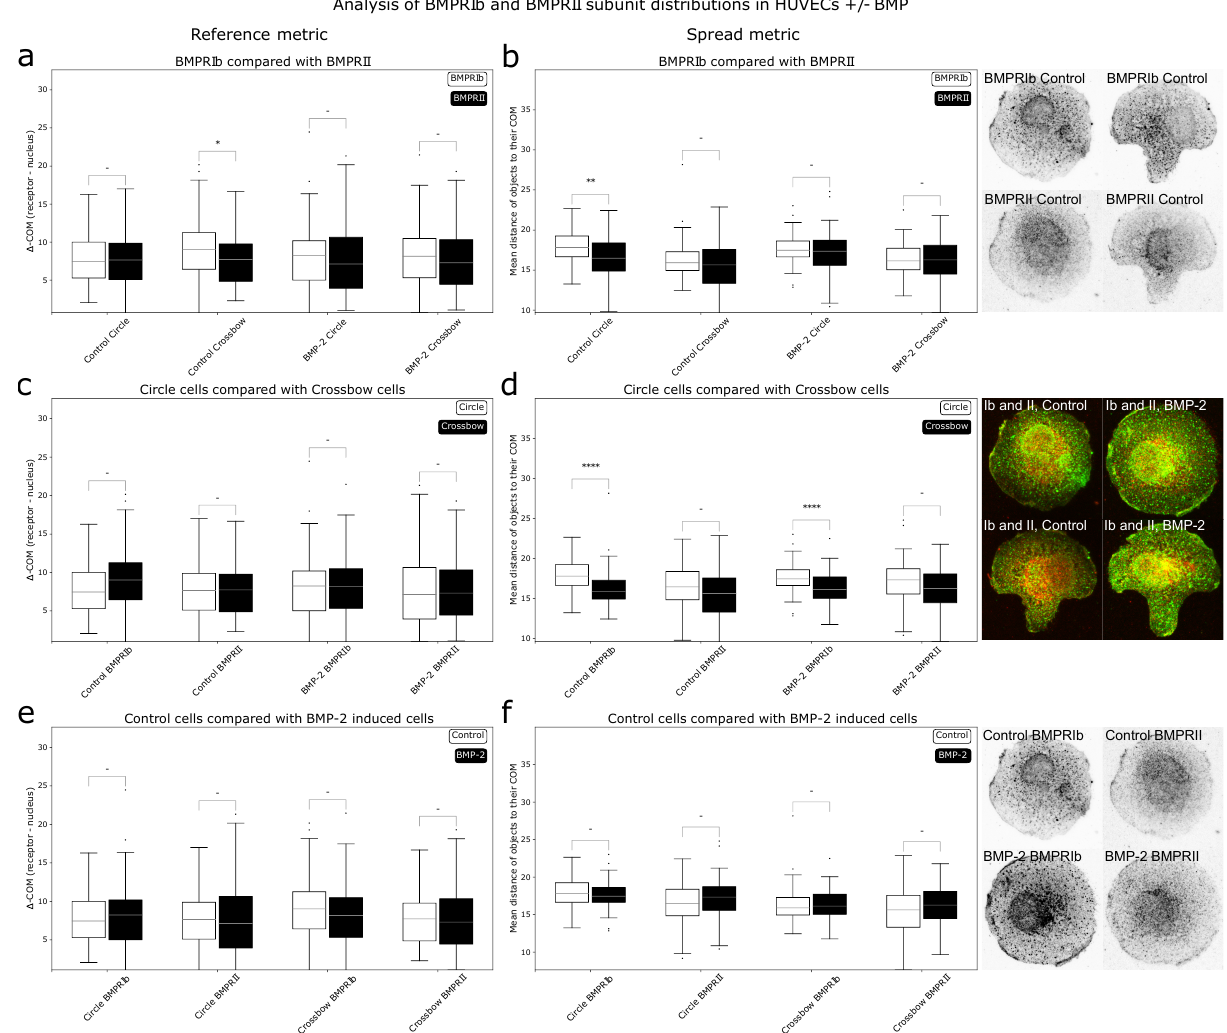
Figure 5. Comparison of receptor distributions of BMPR subunits in HUVECs. ( a , c , e ): reference metric data, ( b , d , f ): spread metric data. Confocal images of cells adhering to micropatterns: Green: BMPRIb, red: BMPRII. ( a , b ): distributions of BMPRIb compared to distributions of BMPRII. Differences in shift could be observed in crossbow cells under control conditions ( p ≈ 0.026). Also, differences could be observed between BMPRIb and BMPRII ( p ≈ 10 − 3 ) in circular cells without BMP, indicating a preference for BISC. ( c , d ): Comparison of circle and crossbow cells. No significant differences in shift could be found. BMPRIb is more spread out in circle than in crossbow cells, both under control and BMP conditions ( p ≈ 10 − 6 and p ≈ 5 · 10 − 5 respectively). ( e , f ): control cells compared with cells that were induced with BMP-2. Control and BMP-2 treated cells do not show a significant difference in receptor distribution; this suggests, that majority of BMPRs were not internalizing simultaneously after addition of BMP. * = p < 0.05, ** = p < 0.01, **** = p < 0.0001, - = not